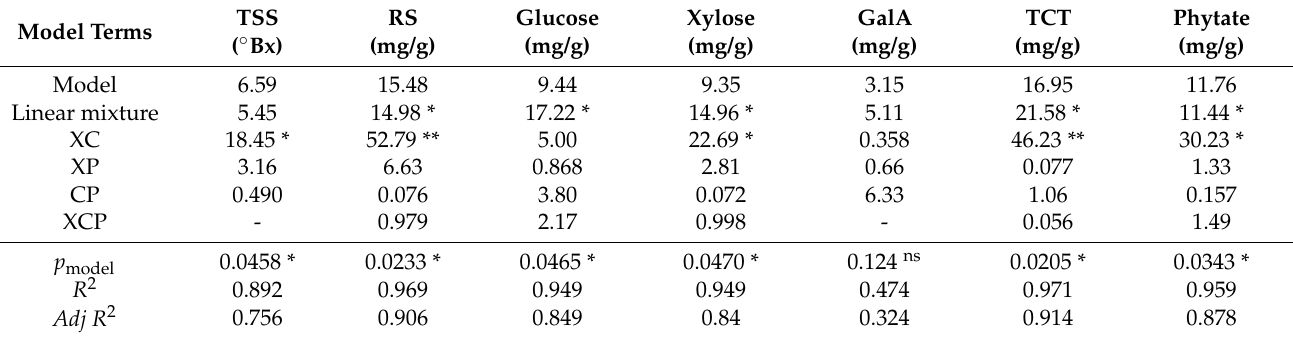
Table 3. Results of two-way analysis of variance (ANOVA) showing Fisher’s F-statistic and model significance of different proportions of individual enzymes in the mixture on the yield of pericarp constituents from sorghum grain following enzymatic